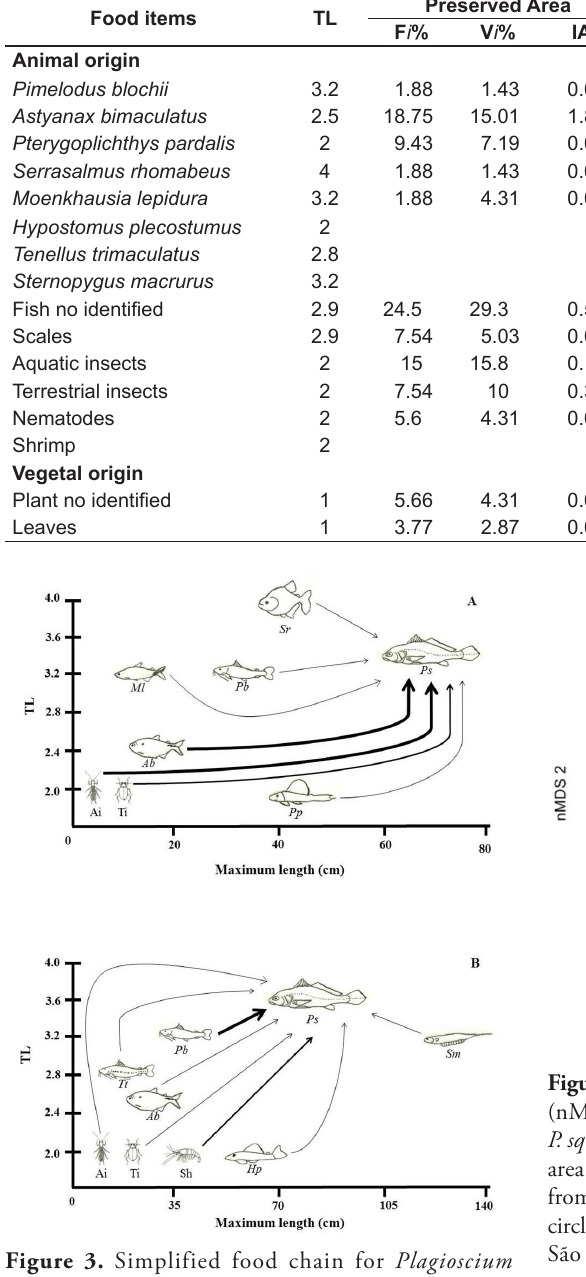
Table 2. Trophic level (TL), occurrence frequency (F i %), volumetric frequency (V i %), and feeding index (IAi) for diet items from P. squamosissimus at preserved area and impacted area of Machado River, Brazil (June 2013 to March 2015). Item relevance ranking, based on IAi, was tested using χ 2.